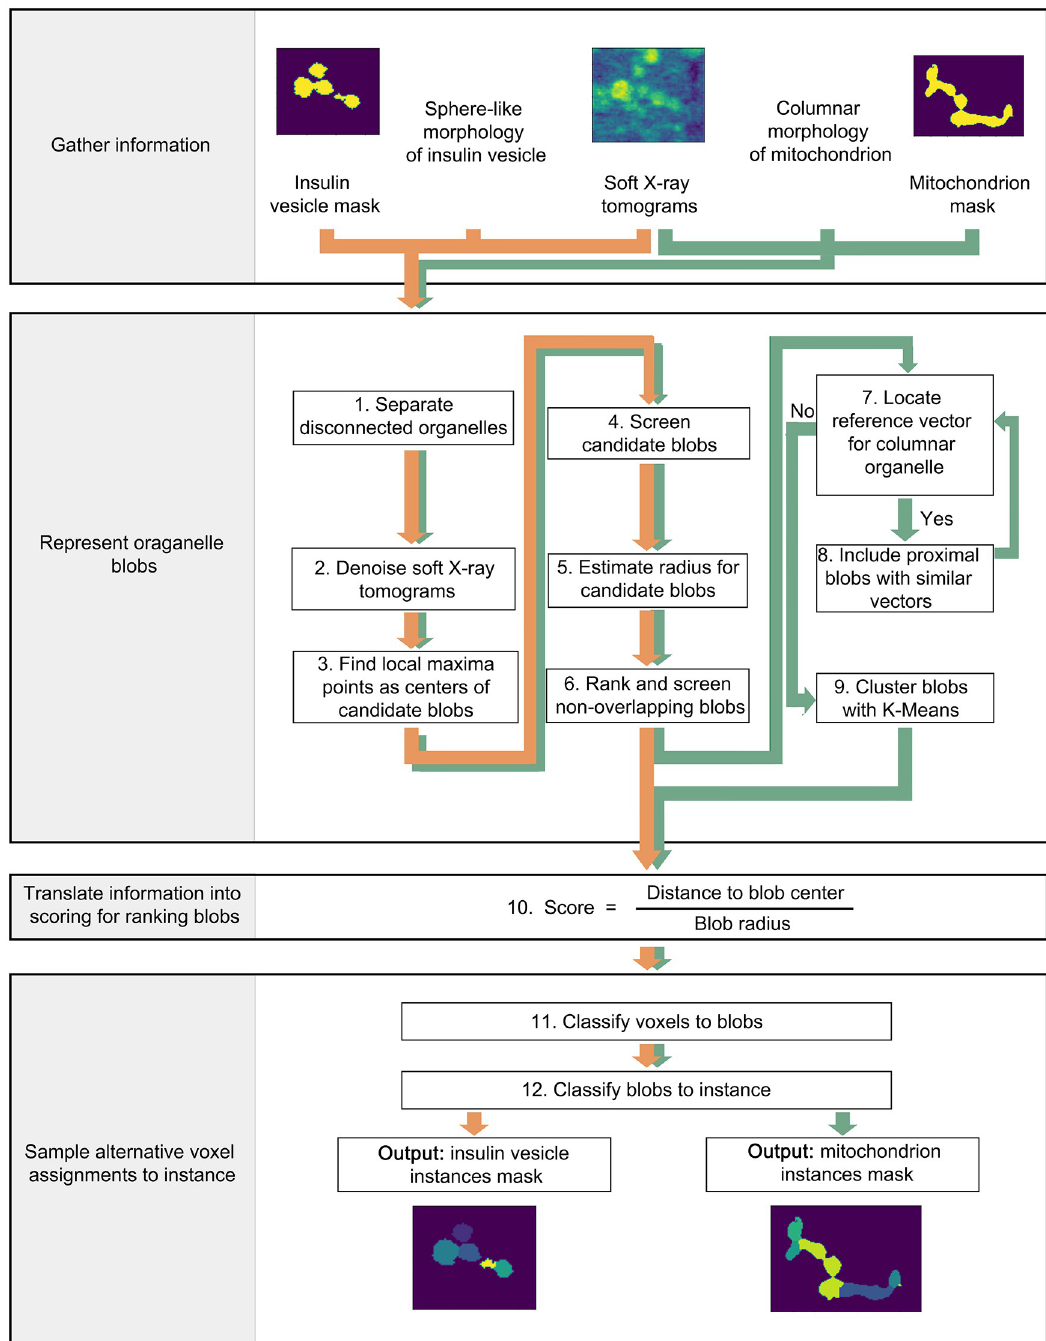
Fig 1. Workflow of the post-processing tool to separate insulin vesicle and mitochondria instances. Orange arrows indicate steps to separate insulin vesicle instances, while green arrows indicate steps to separate mitochondria instances. All steps are processed in 3D